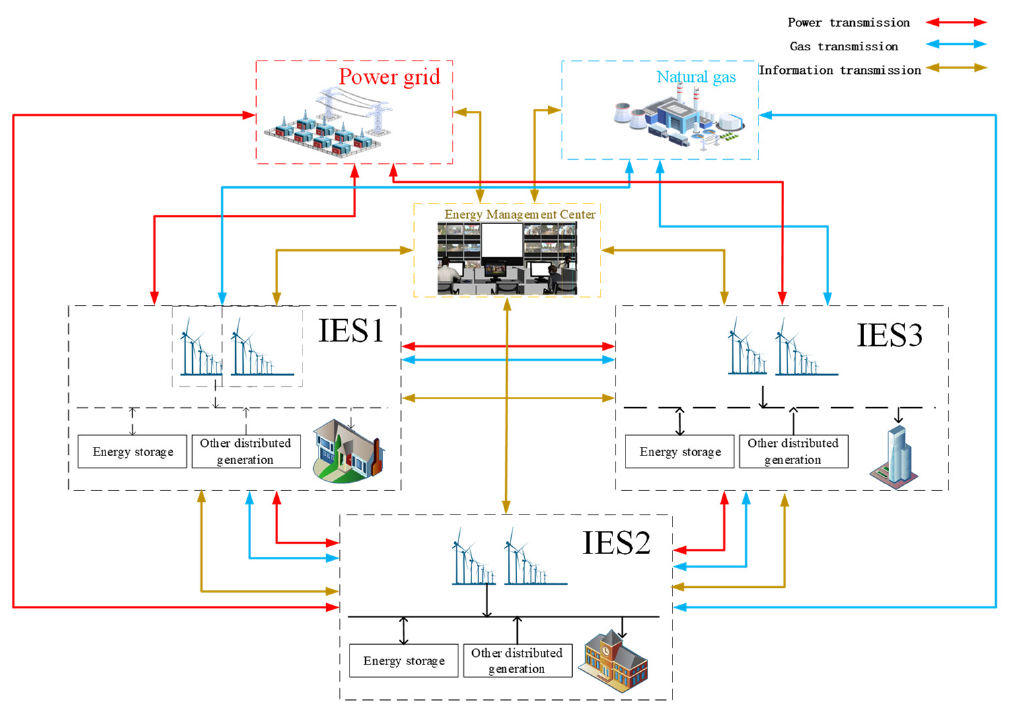
Figure 2. Low-carbon energy sharing framework of multiple regional gas–electric integrated energy systems.